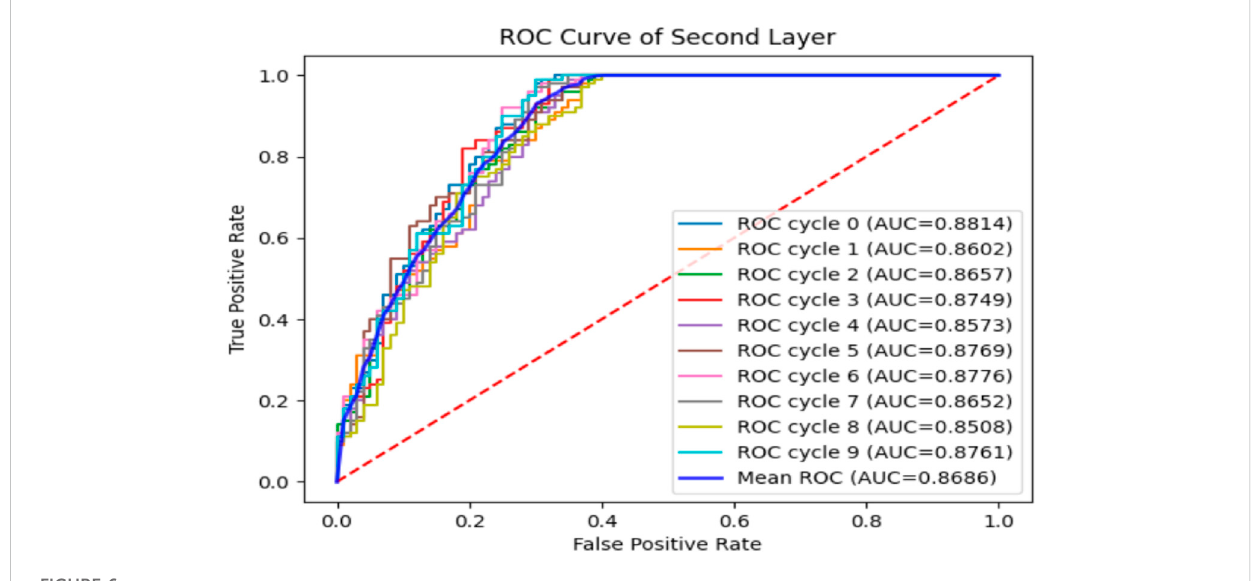
FIGURE 6 ROC curves for layer 2 (enhancer strength prediction).